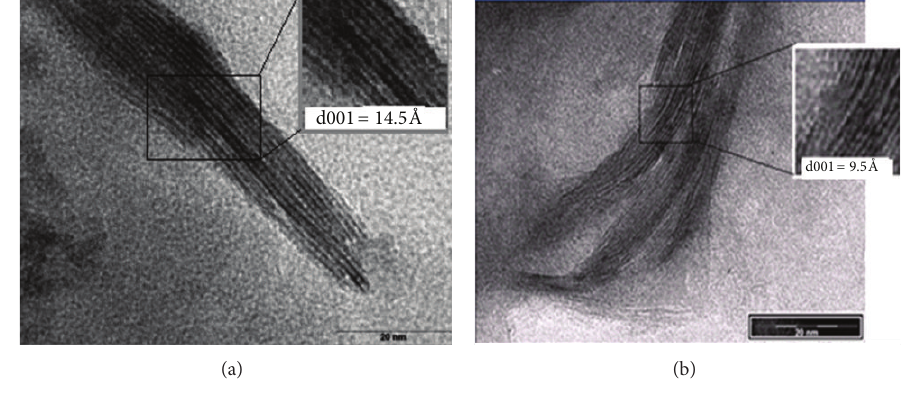
Figure 3: TEM observations of RBC (a) and RGC (b).